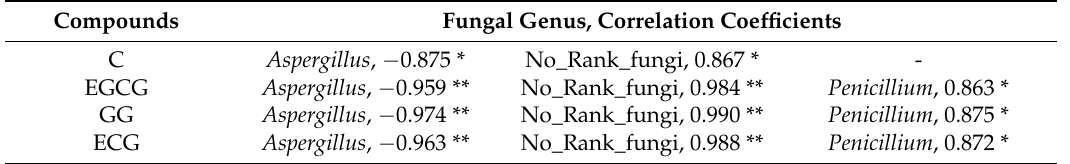
Table 5. Significant correlation coefficients between contents of the tea chemical compounds and the fungal